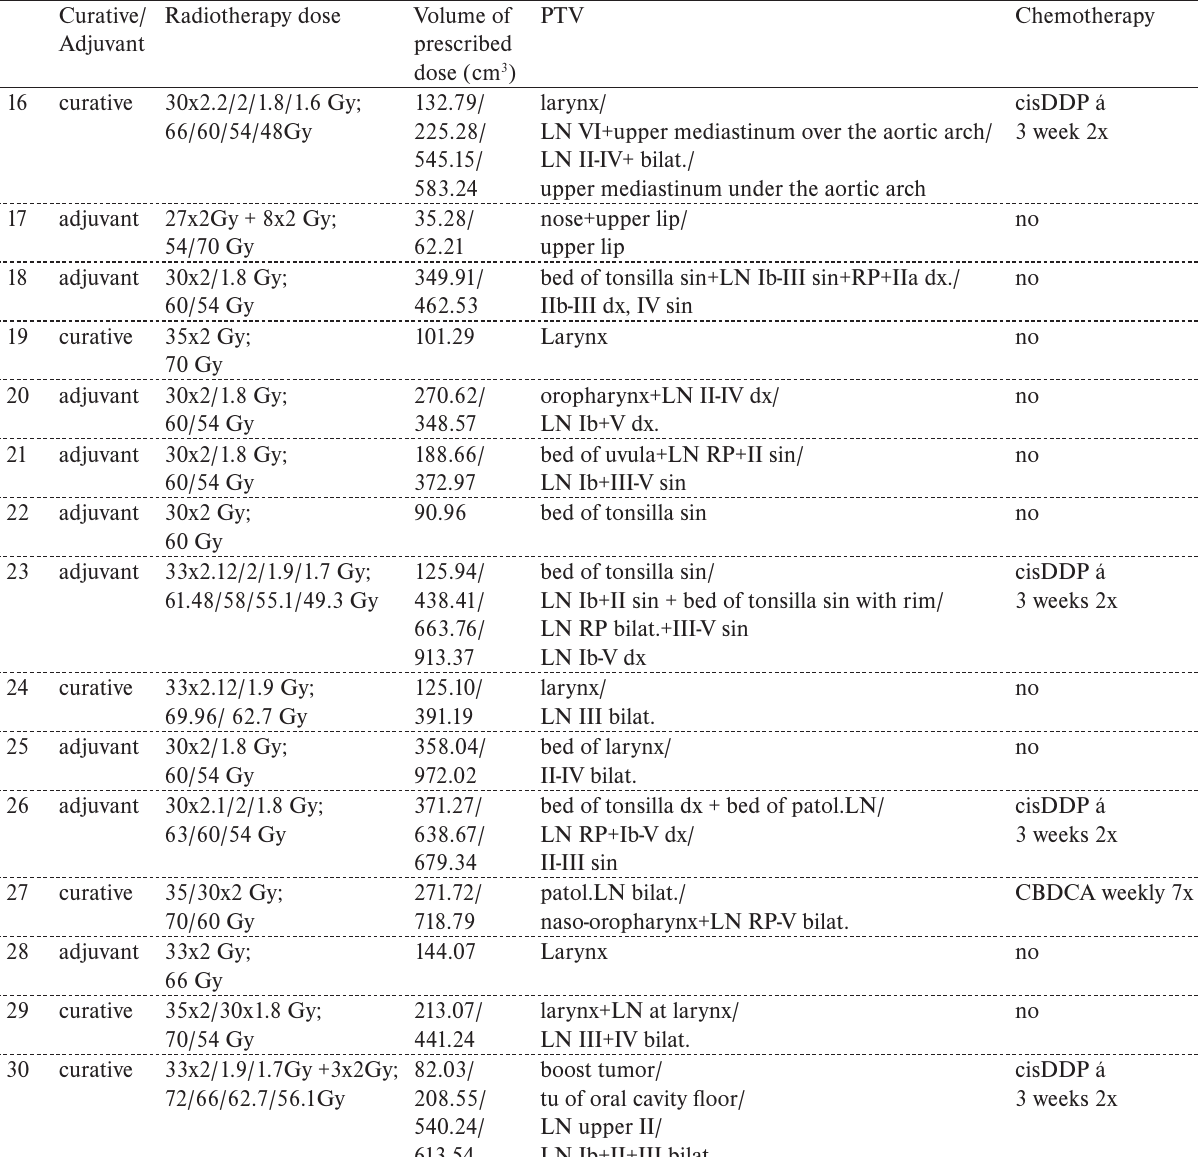
Table 3. Individual characteristics of patients from control arm: type oftreatment, dose, volumeofradiotherapy, ptv,